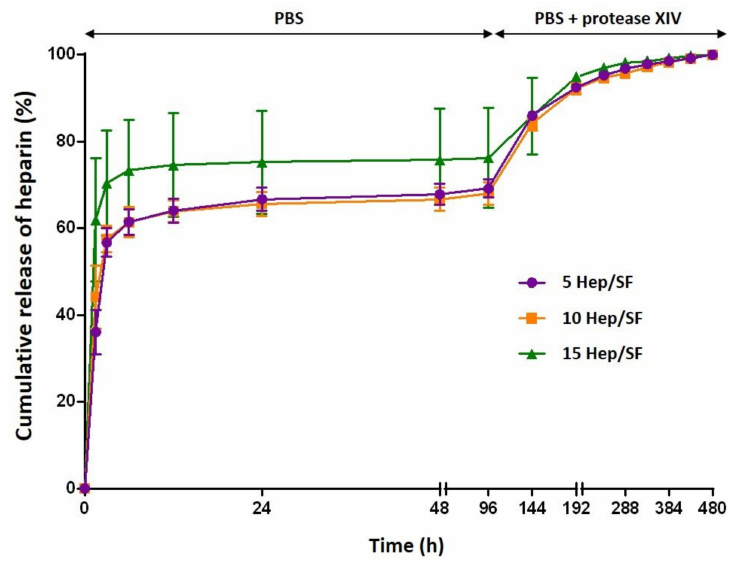
Figure 2. Percentages of cumulative release profiles of LMWH from ( − o − ) 5, ( − (cid:3) − ) 10, and ( − ∆ − ) 15 Hep/SF films under PBS and PBS containing protease